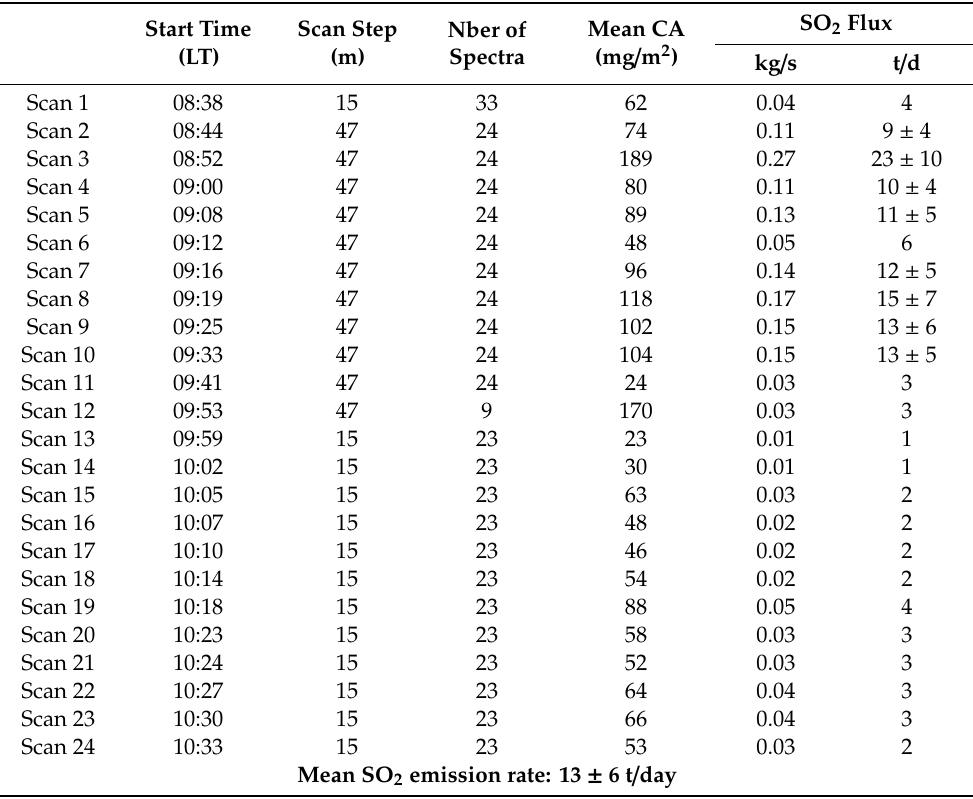
Table 2. SO 2 flux obtained from two hours of scanning